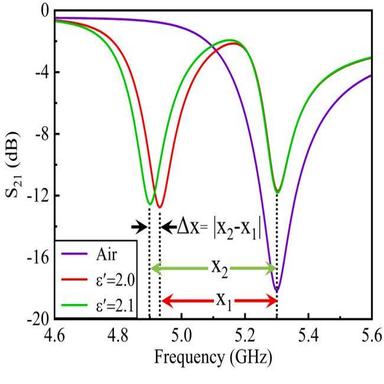
Resolution of the sensor.